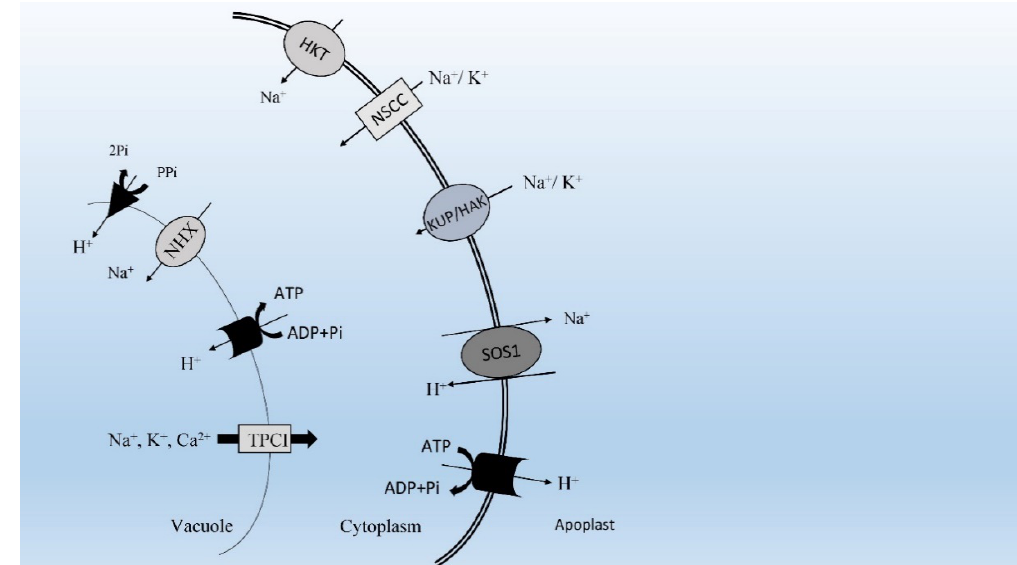
Figure 1. Sodium transport at the cellular level. Schematic representation of transport systems involved in Na + transport at the plants through the plasma membrane or the tonoplast. Primary transport systems consisting of proton pump ATPases on the plasmalemma and the tonoplast and a pyrophosphatase on the tonoplast create a pH gradient and a potential di ff erence electric on both sides of the membranes (cytosolic side more alkaline and charged more negatively). Proton concentration gradients allow Na + excretion of cytoplasm towards the outside environment or the vacuole via the operation of antiports Na + / H + (appealed SOS1 (Salt Overly Sensitive protein 1) on the plasmalemma or NHX1 (K + , Na + / H + antiporter), on the vacuole). Potential gradients electric created by the pumps cause the entry of Na + in the cytoplasm of the cell since the external environment or the vacuole via non-selective cationic channels (NSCC) (CNGC (Cyclic Nucleotide Gated Channels) on the plasma membrane? TPC1 (Two-Pore Channel 1) on the tonoplast) or possibly carriers of the HKT (High-A ffi nity K + Transporters type in some species. At high external concentration, Na + could also enter the cell by borrowing K + carriers KUP / HAK (K + uptake / High-A ffi nity K + . ) type.